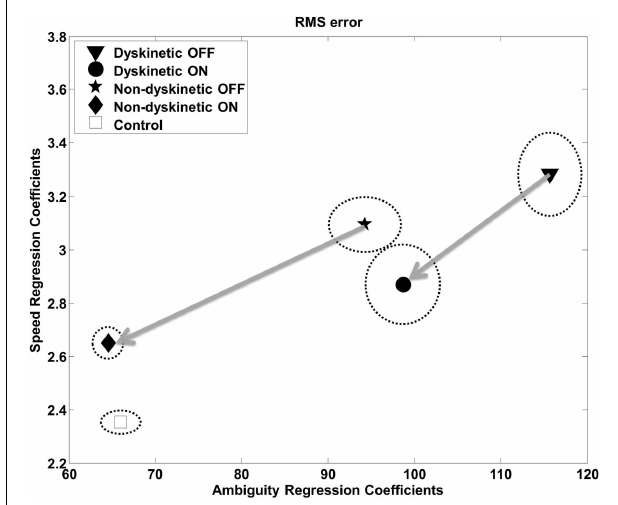
FIGURE 5 | Regression analysis – RMS .The relative contribution of increasing target ambiguity and speed to RMS error is demonstrated.The design matrix for the regression included tracking speed, ambiguity columns, as well as nuisance covariates corresponding to individual subject and overall mean.The units can be considered arbitrary.The vertical and horizontal radii of the ellipses represent the standard error of the regression coefficients as estimated by leave-one-out validation.The arrows are from the same PD subjects OFF medication to ON medication, and thus show the effects of L -DOPA